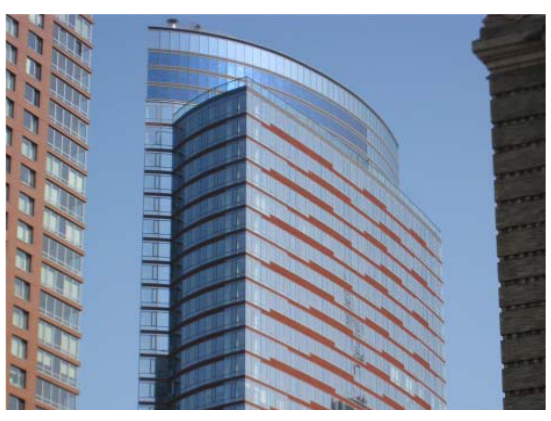
Figure 6. The Visionaire